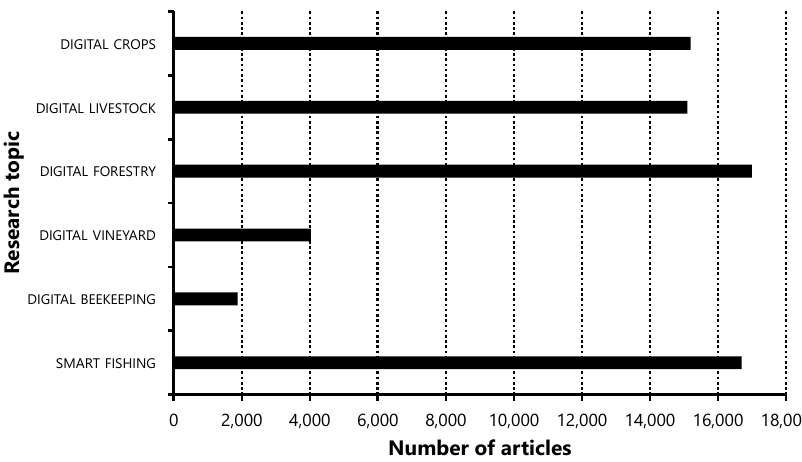
Figure 2. Number of articles on Google Scholar in 2022 for the topics of digital